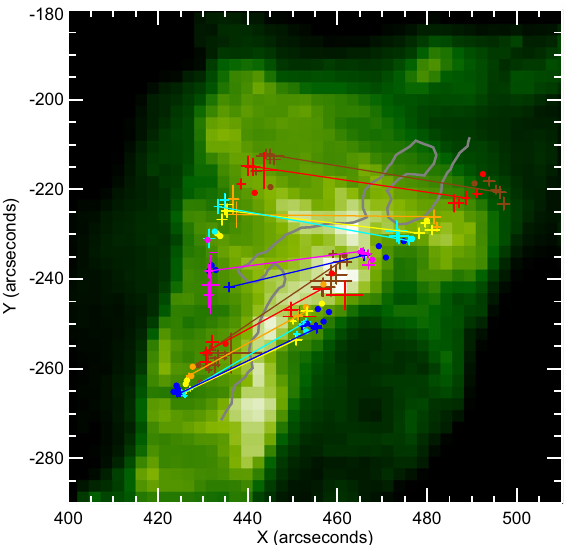
Fig. 8 Still from a movie: Hard X-ray footpoints ( with error bars ) observed with the RHESSI satellite during the flare SOL2002-11-09. Simultaneous footpoints are connected by a line colored sequentially with time. The footpoint information is overlaid on a SOHO/EIT image at 195 Å, indicating enhanced density in the corona. The movie shows two simultaneous footpoints connected by a vertical half-circle . The flux at each footpoint is indicated by the size of the purple circle at logarithmic scale (see Grigis and Benz 2005a). Movie courtesy of Paolo Grigis